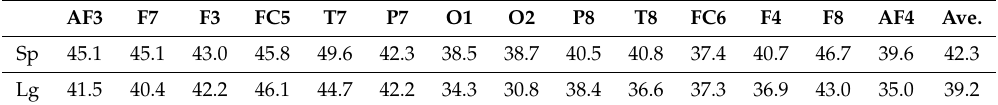
Figure 9. ( a ) EEG power spectrum and ( b ) its logarithmic spectrum. Table 2. EERs (%) when using the log power spectrum.